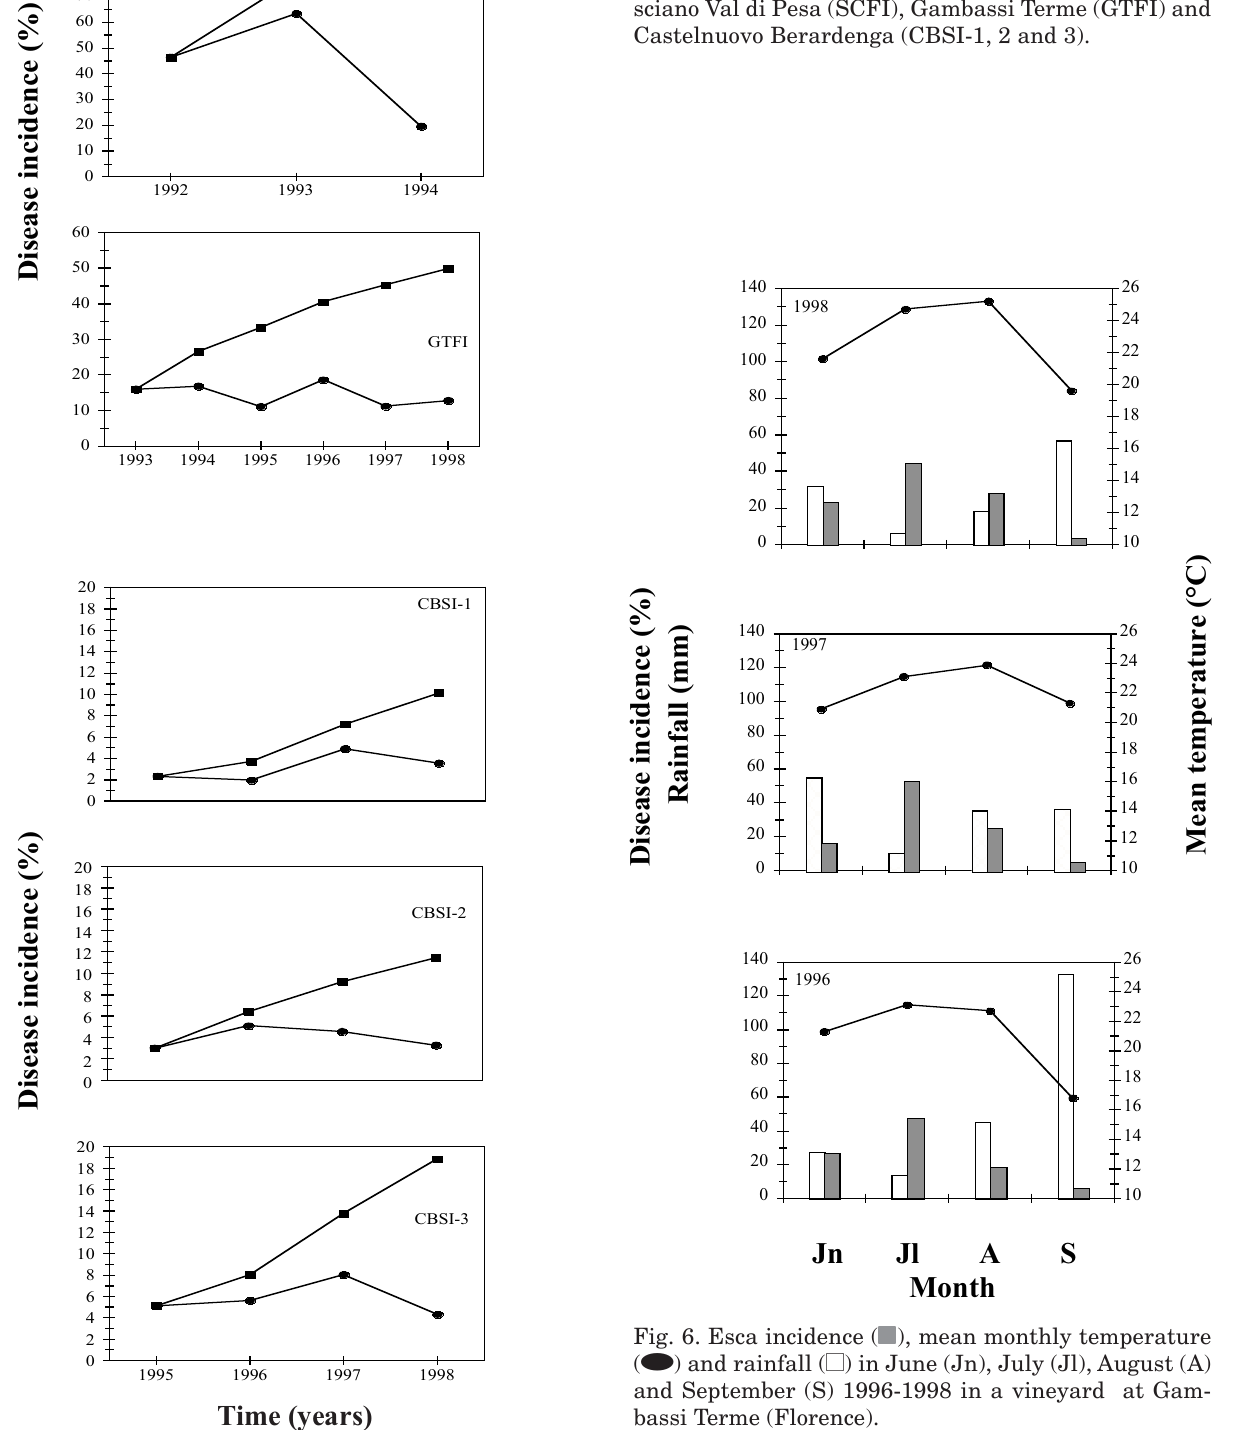
(Florence).Fig. 5 (left column). Annual ( (cid:2) ) disease incidence and cumulated incidence ( (cid:1) ) in five vineyards at San Ca- sciano Val di Pesa (SCFI), Gambassi Terme (GTFI) and Castelnuovo Berardenga (CBSI-1, 2 and